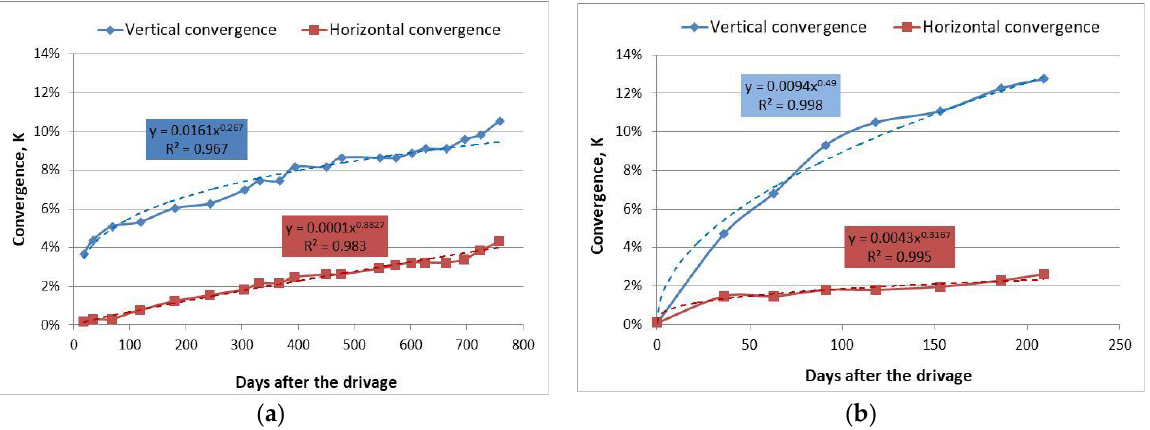
Figure 7. Development of convergence of roadways — underground measurements. ( a ) The 595th meter of roadway D-2. ( b ) The 405th meter of roadway F-33.